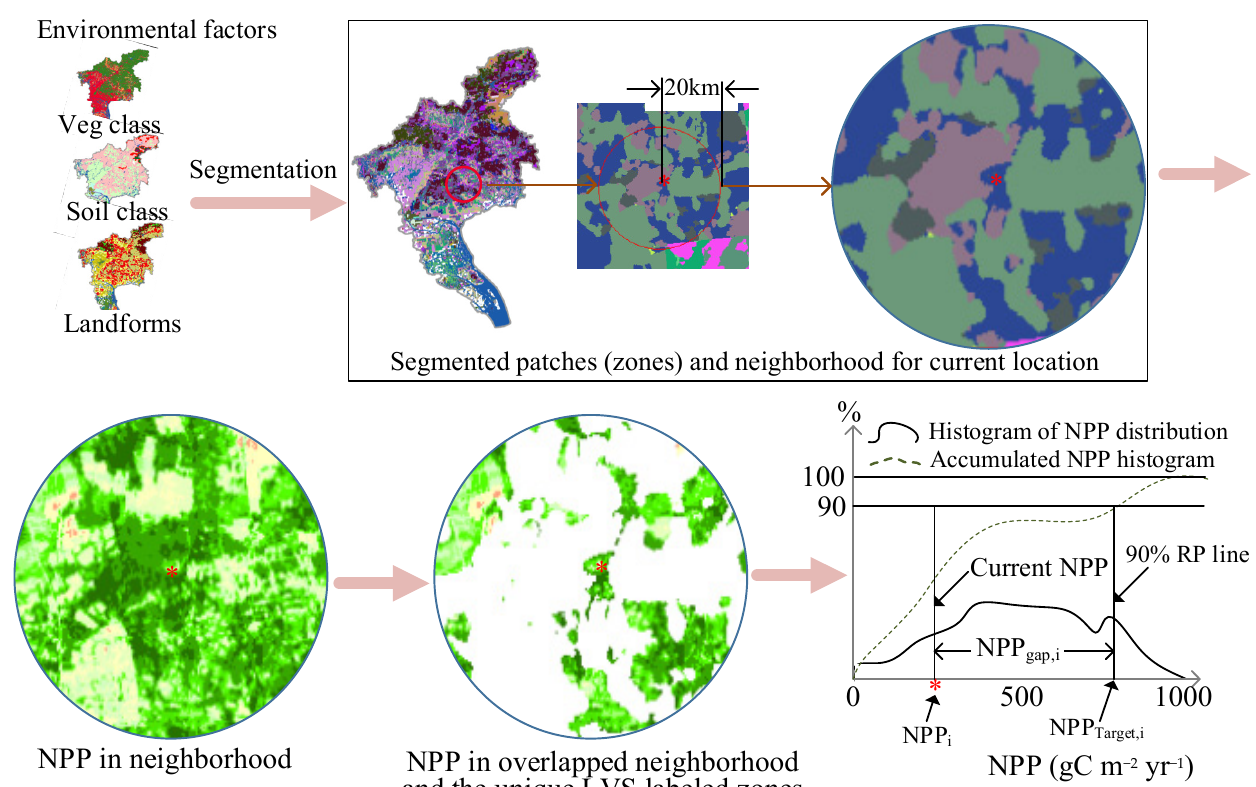
Figure 2. Workflow for computing carbon uptake potential from urban vegetation with implemen- tation of optimal LMPs. The diagram shows segmentation of environmentally homogeneous patches (zones), the unique LVS# for a given location i, the neighborhood, NPP distribution of the location, and the overlapped area of the LVS zones and neighborhood to derive NPP Target,i and NPP gap,i or the potential of carbon uptake. The computation of carbon uptake potential is repeated for all locations in the study region.